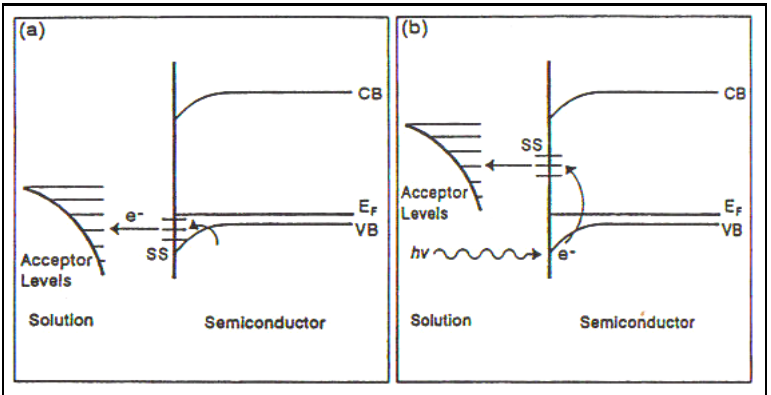
Figure 7. Representation of a “good” surface state on a semiconductor electrode. ( a ) Thermal activation and ( b ) photoexcitation of an electron from the valence band to surface states (Reprint from [29]).